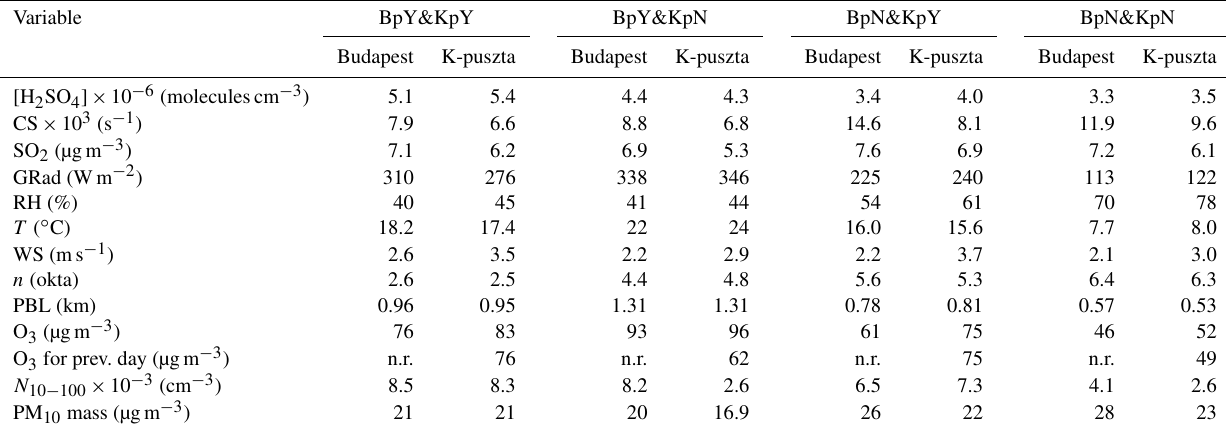
Table 4. Medians of gas-phase H 2 SO 4 concentration, condensation sink (CS), SO 2 concentration, global radiation (GRad), relative humidity (RH), air temperature ( T ) , wind speed (WS), cloudiness ( n) , planetary boundary layer (PBL) height, O 3 concentrations on the actual day and previous day, aerosol particle number concentration in the diameter range from 10 to 100nm ( N 10 − 100 ) , and PM 10 mass concentration for the time interval when NPF events were identified in both Budapest and at the K-puszta station (BpY&KpY) and when there was an event in Budapest and no event at the K-puszta station (BpY&KpN), no event in Budapest and an event at the K-puszta station (BpN&KpY), and no event in both Budapest and at the K-puszta station